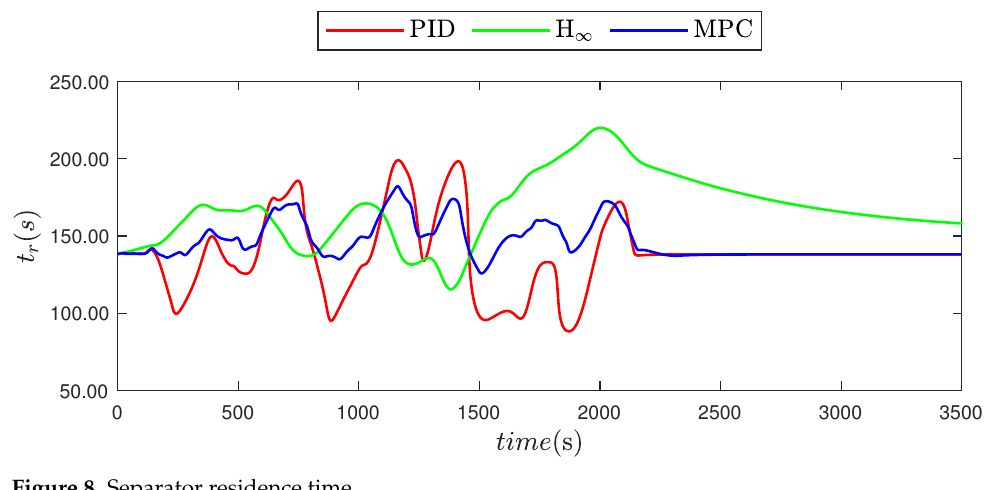
Figure 8. Separator residence time.